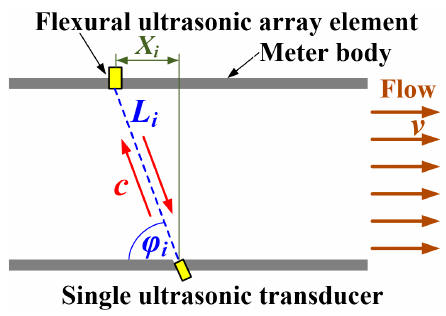
Figure 2. The principle of the transit-time ultrasonic flow measurement method.